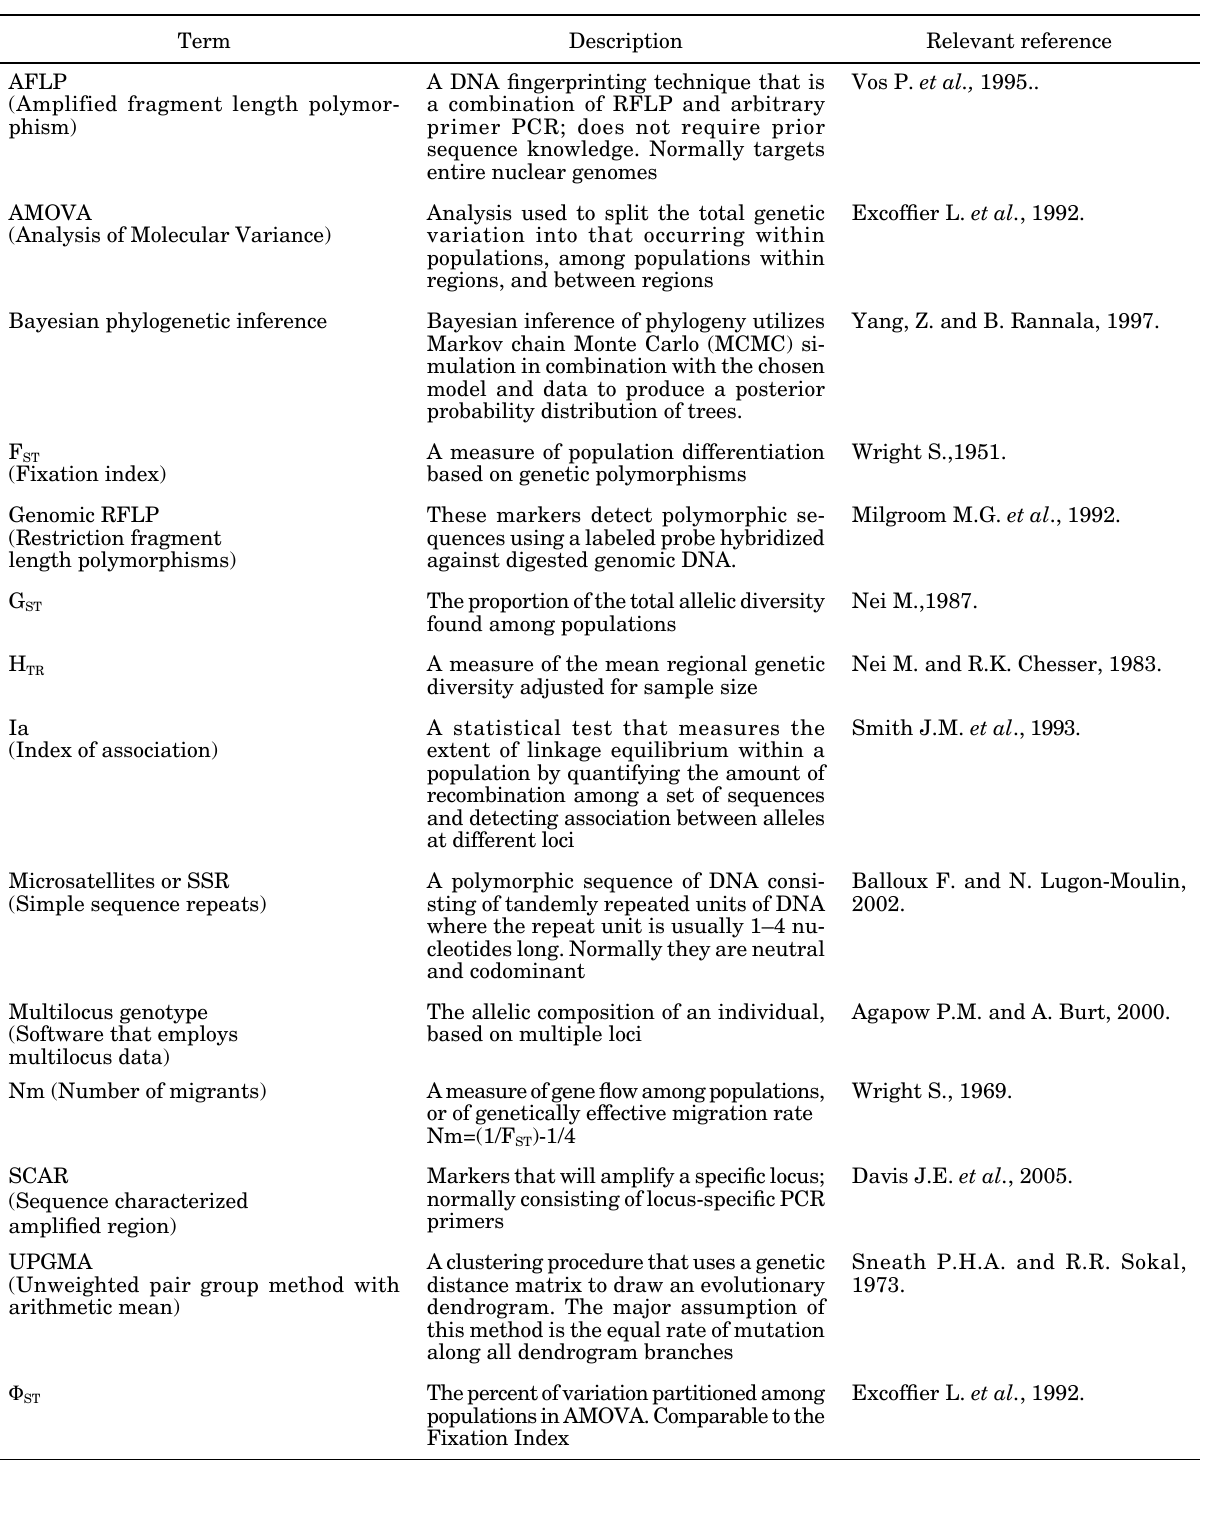
Table 2. A glossary of population genetics terms and techniques named in the